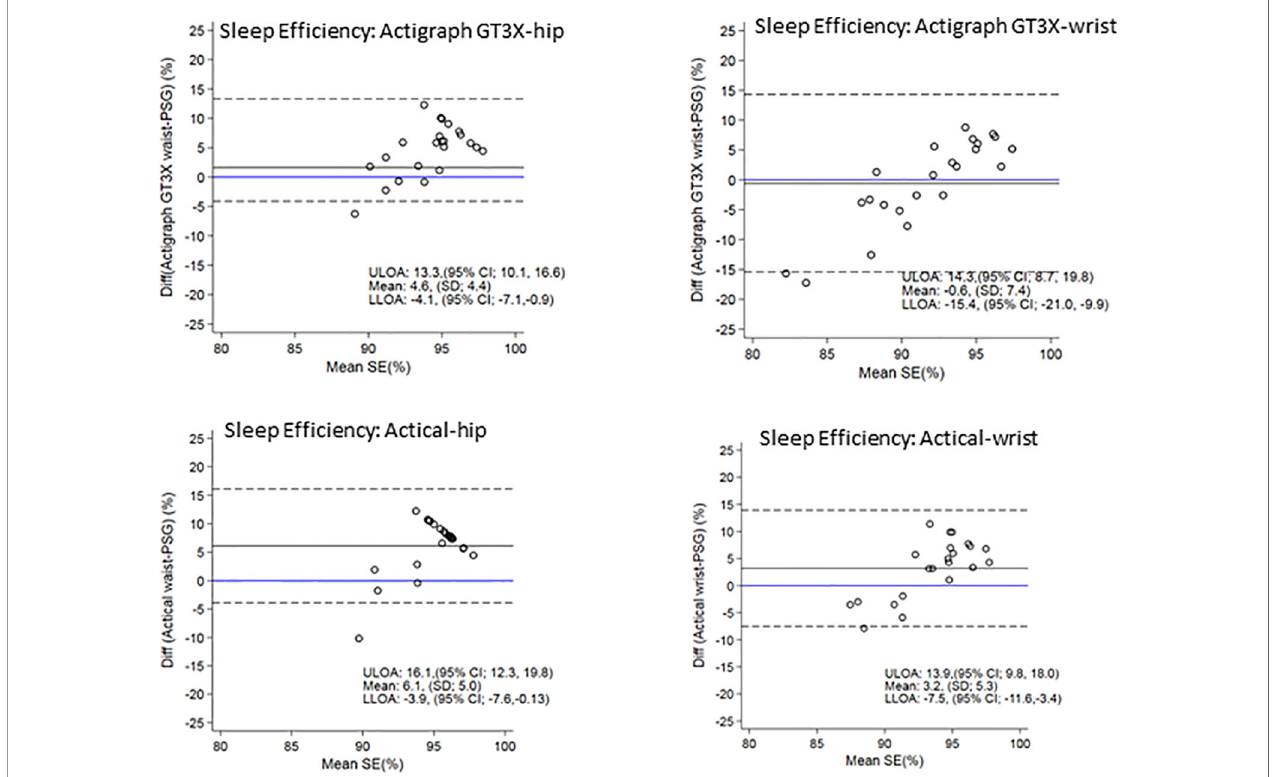
FIGURE 4 | Bland Altman plots of TST differences between Acticals and PSG are on the y-axis and means are on the x-axis. Perfect agreement is shown by the blue line crossing zero on the y-axis. Mean differences are represented by black solid lines and the upper and lower levels of agreement by dashed lines. ULOA, Upper Limit of Agreement; LLOA, Lower Limit of Agreement; TST, Total Sleep